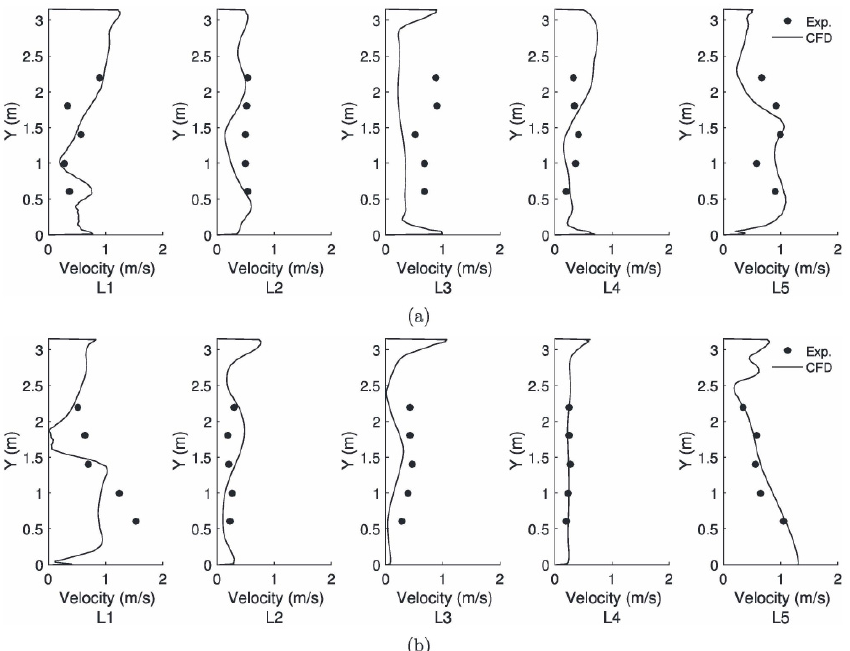
Figure 4. Velocity profiles for ( a ) the hard floor configuration and ( b ) the raised floor configuration with open aisles.